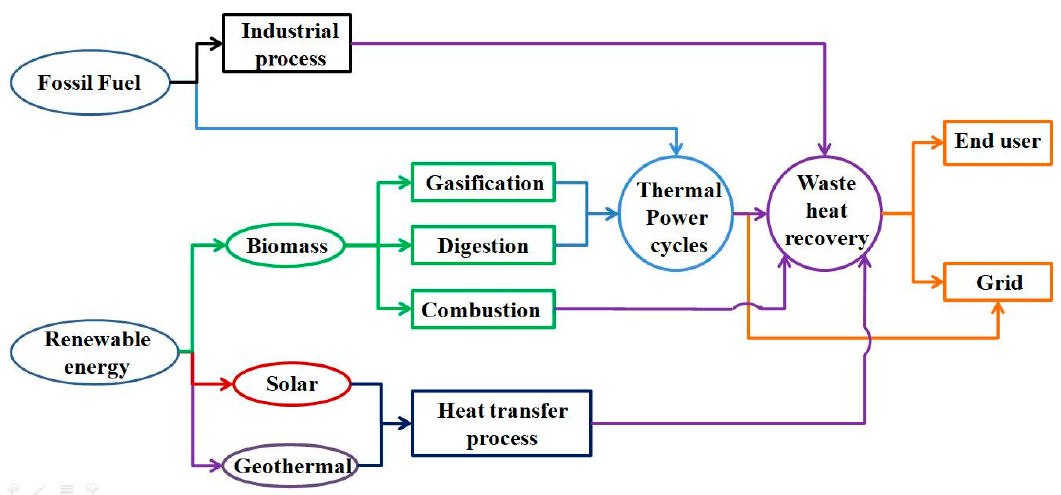
Figure 2. Waste heat recovery from various heat sources [13].